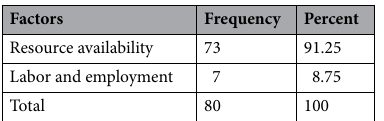
Table 8. Factors driving the activities of SMFEs.